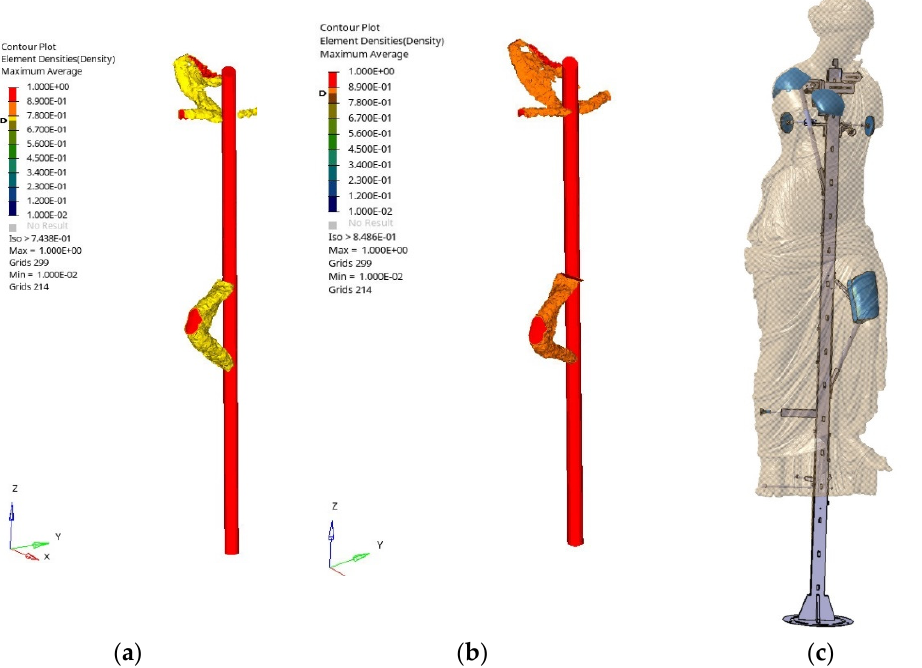
Figure 11. ( a ) Solution obtained through TO due to CB_sa; ( b ) Solution obtained through TO due to CBWA_sa; ( c )